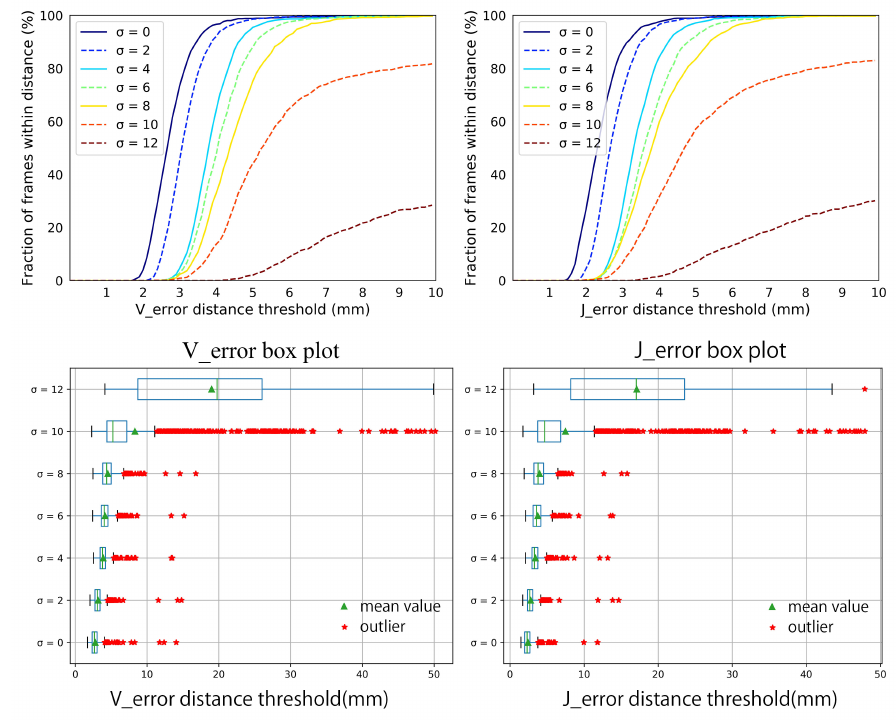
Figure 16. The V error and J error of our system with different noise in the synthetic